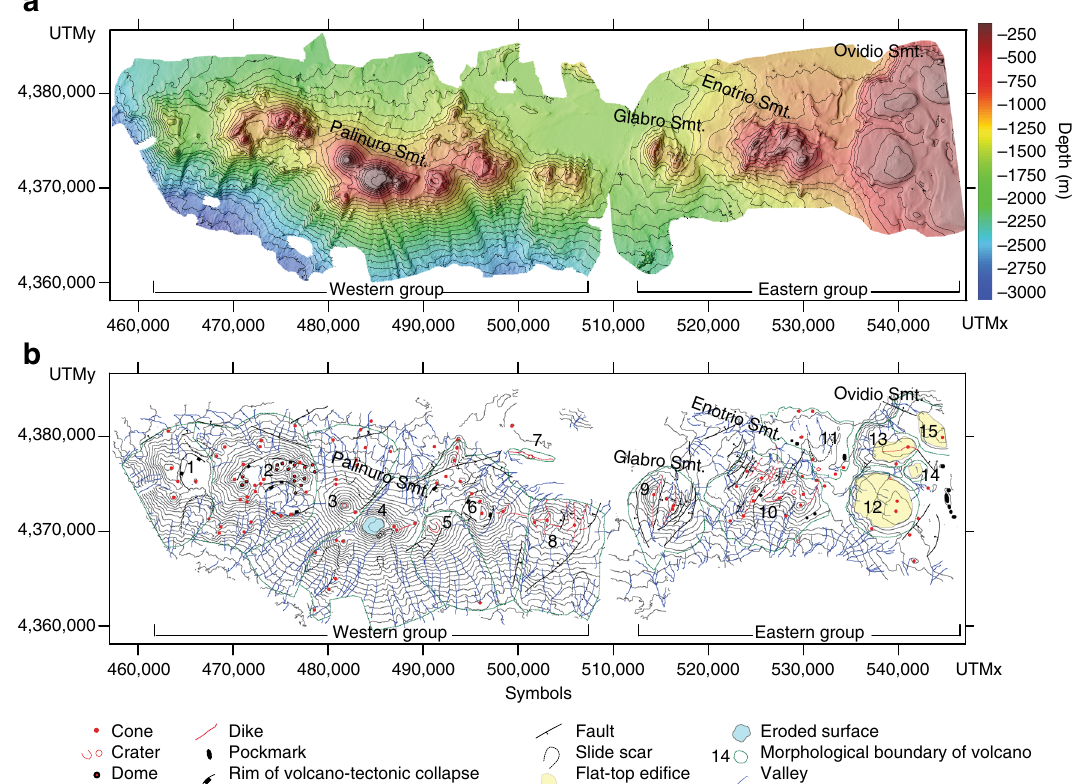
Fig. 2 Bathymetry and morphostructural setting of the Palinuro STEP volcanic chain. a Shaded relief and bathymetry of the 25 m × 25 m STEP Volcanic Chain Digital Terrain Model (WGS85, UTM Zone 33N; see auxiliary material); the contour lines are 100 m spaced. b Morphological map of the STEP volcanic chain with the main volcanoes marked by